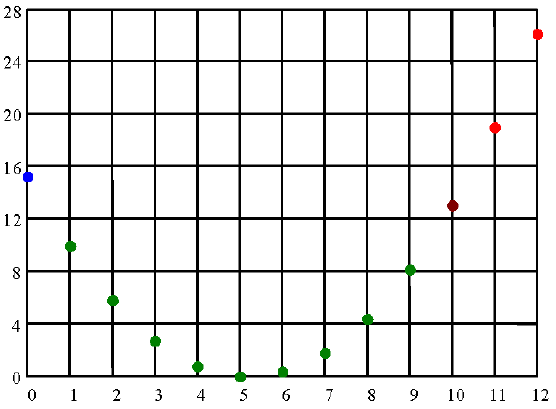
Figure 3. Value of X 2 statistic as function of independent observation x